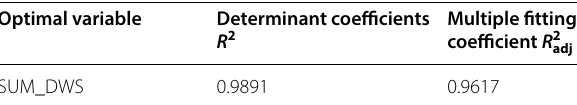
Table 2 Calibration results Optimal variable